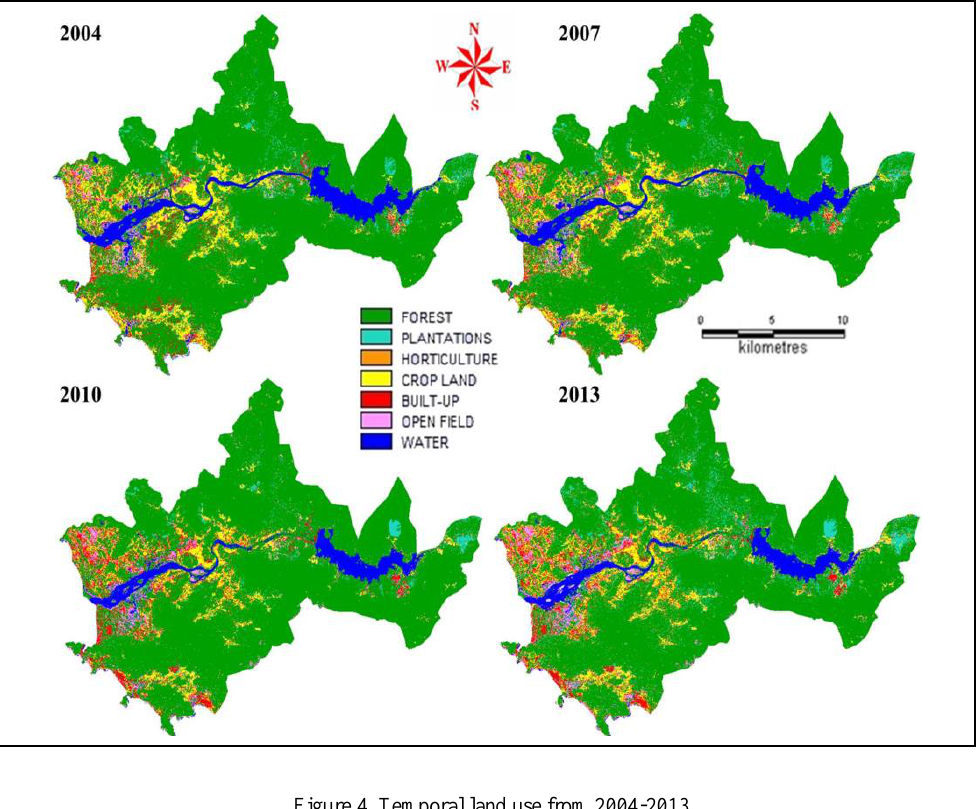
Figure 4. Temporal land use from 2004-2013.